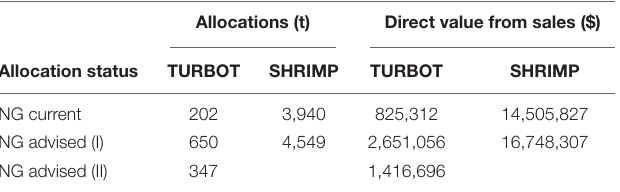
TABLE 1 | Current and advised allocations (in t) and Direct value (in $ CAD) of sales for current and advised turbot (2 + 3KLMNO) and shrimp allocations (SFA 4, 5) to the Nunatsiavut Government